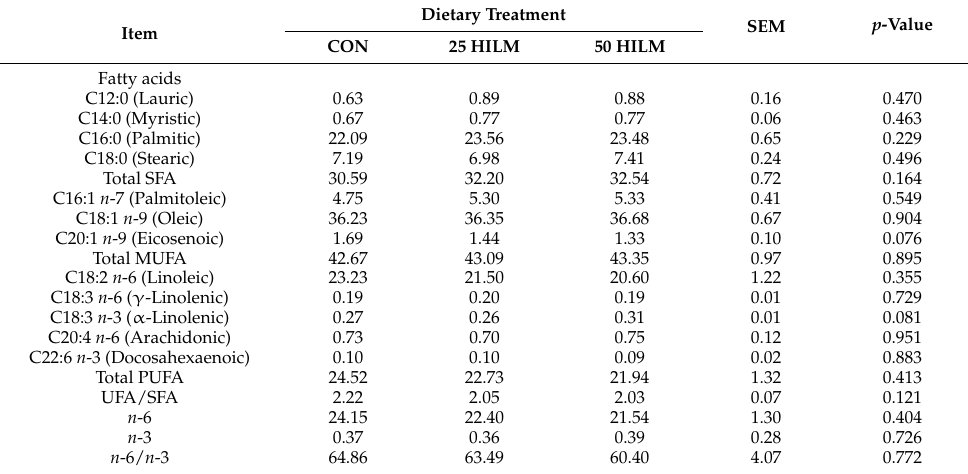
Table 6. Effect of dietary Hermetia illucens larvae meal (HILM) inclusion level on the fatty acid profile in leg meat of broiler